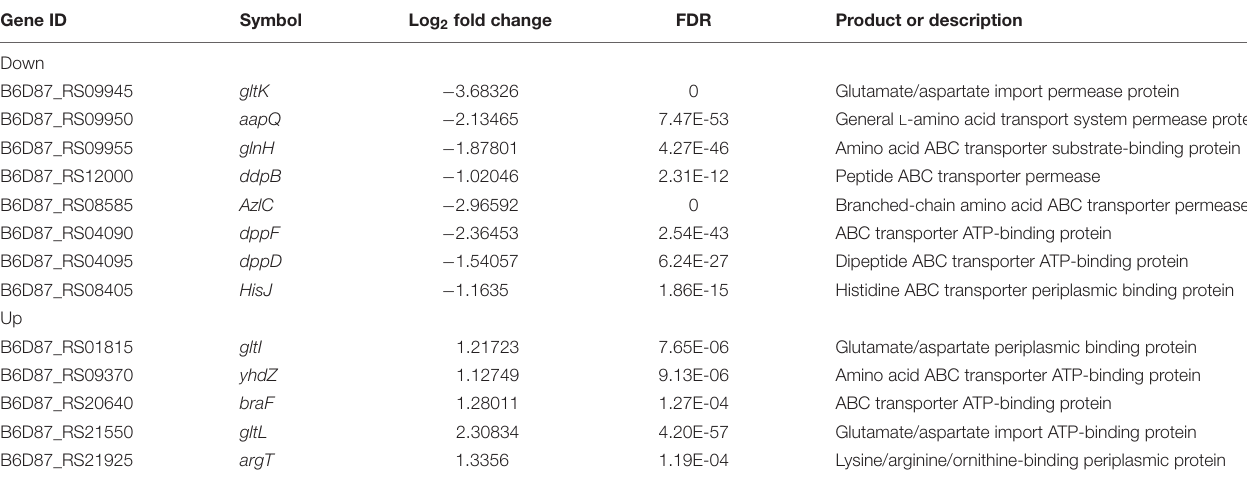
TABLE 1 | Differentially expressed genes related to the transport of amino acids or